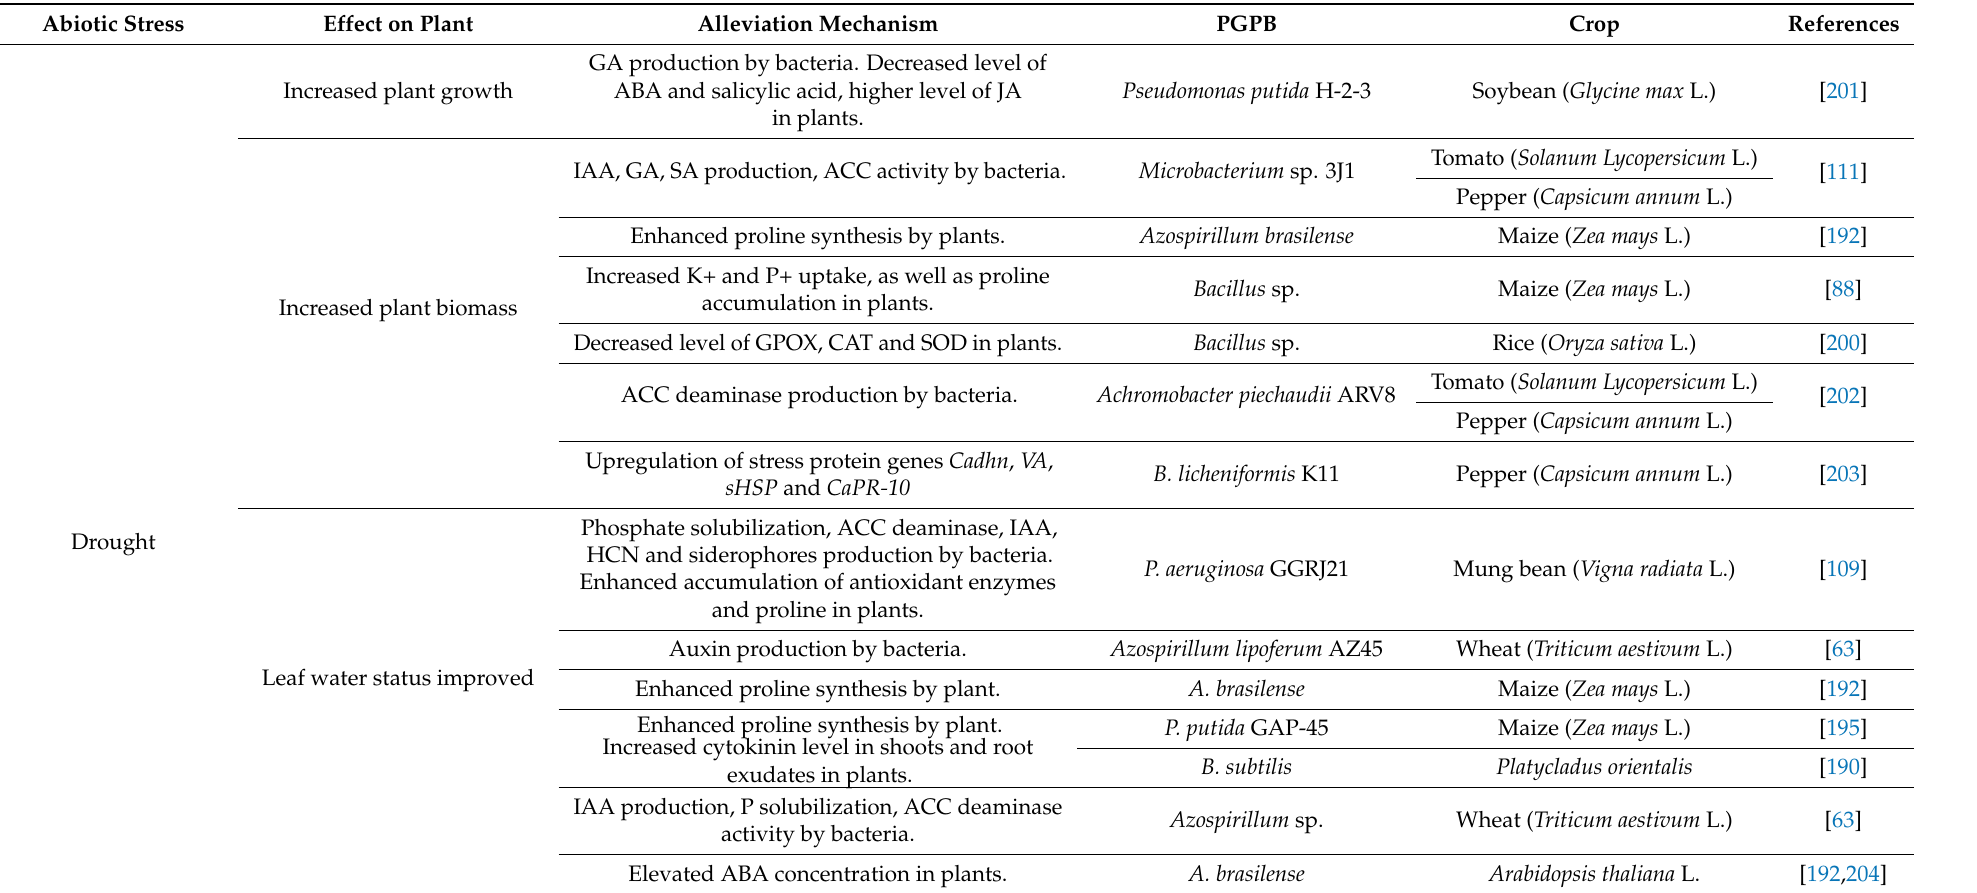
Table 1. Plant growth-promoting bacteria (PGPB) and their induced changes in plant morphological and physiological molecular traits with alleviation mechanisms under drought and salinity